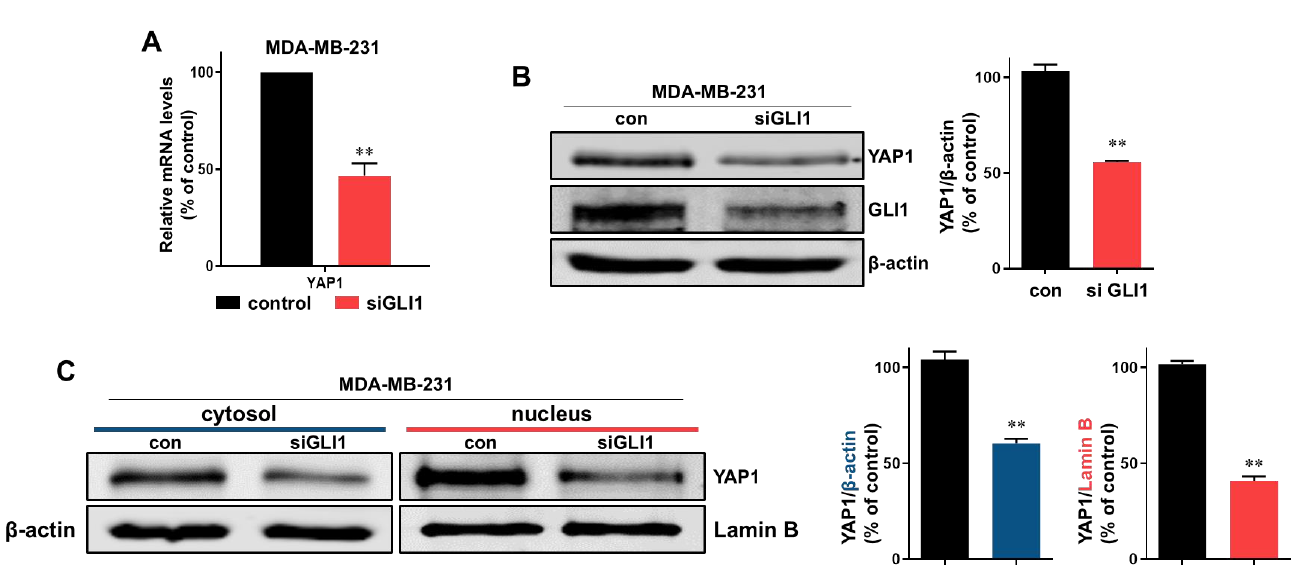
Figure 6. Down-regulation of YAP1 by knockdown of GLI1. ( A ) Effect of down-regulation of GLI1 on YAP1 gene expression. MDA-MB-231 cells were transfected with siRNA of GLI1. After extraction of protein, the transcript level of YAP1 was assessed. ( B ) Effect of down-regulation of GLI1 on YAP1 protein expression. MDA-MB-231 cells were transfected with siRNA of GLI1. After extraction of protein, the protein levels of YAP1 were assessed. ( C ) The cytosolic and nuclear protein levels of YAP1 were also decreased in cells transfected with siRNA of GLI1. Representative Western blot images of triplicate experiments are shown as mean ± SD. * p < 0.05, ** p < 0.01 vs. DMSO-treated control.